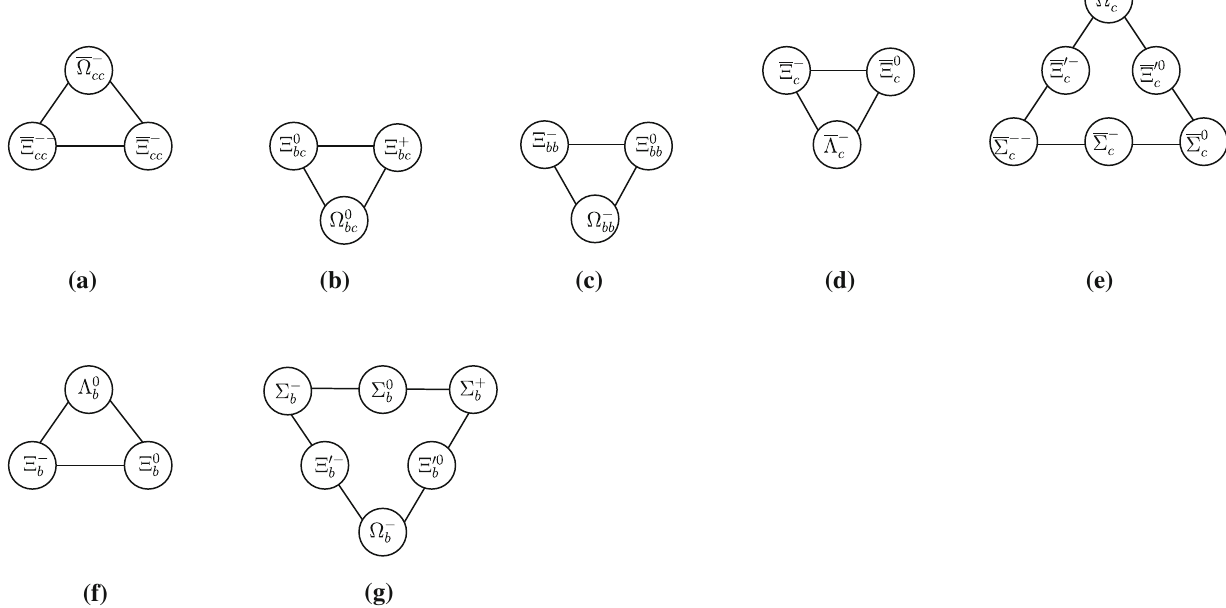
Fig. 2 The weight diagrams for the doubly heavy baryon are given in a – c , which anti-triplet F cc to be ( a ), triplet F bc to be ( b ), or triplet F bb to be ( c ). The singly anti-charm baryon multiplets are F c 3 , F c ¯